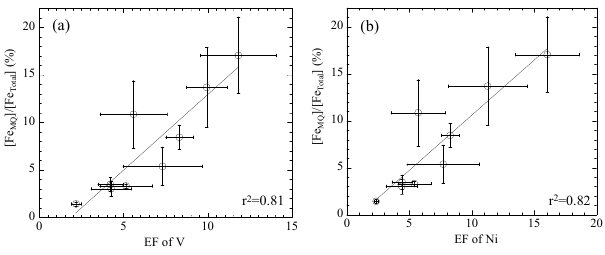
12(b)(a) Fig. 12. Relationship of the EFs of (a) V and (b) Ni with the MQ water-soluble fraction of Fe. Error bars are standard deviations ob- tained by three independent